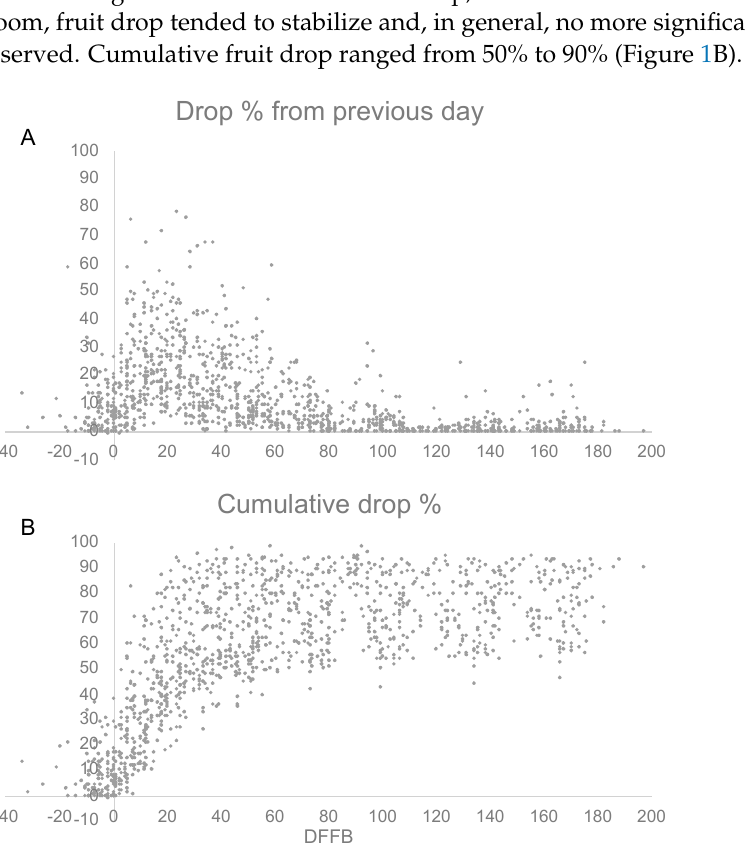
Figure 1. Fruit drop percentage from previous sampling day ( A ) and cumulative fruit drop percentage of almond crop along days from full bloom (DFFB) ( B ) at Les Borges Blanques, Spain. Each dot represents the average of trees during 2015–2018. Data belongs to twenty different cultivars (P1), two almond cultivars grafted onto eight to ten rootstocks (P2), and two cultivars with three different pruning types (P3).